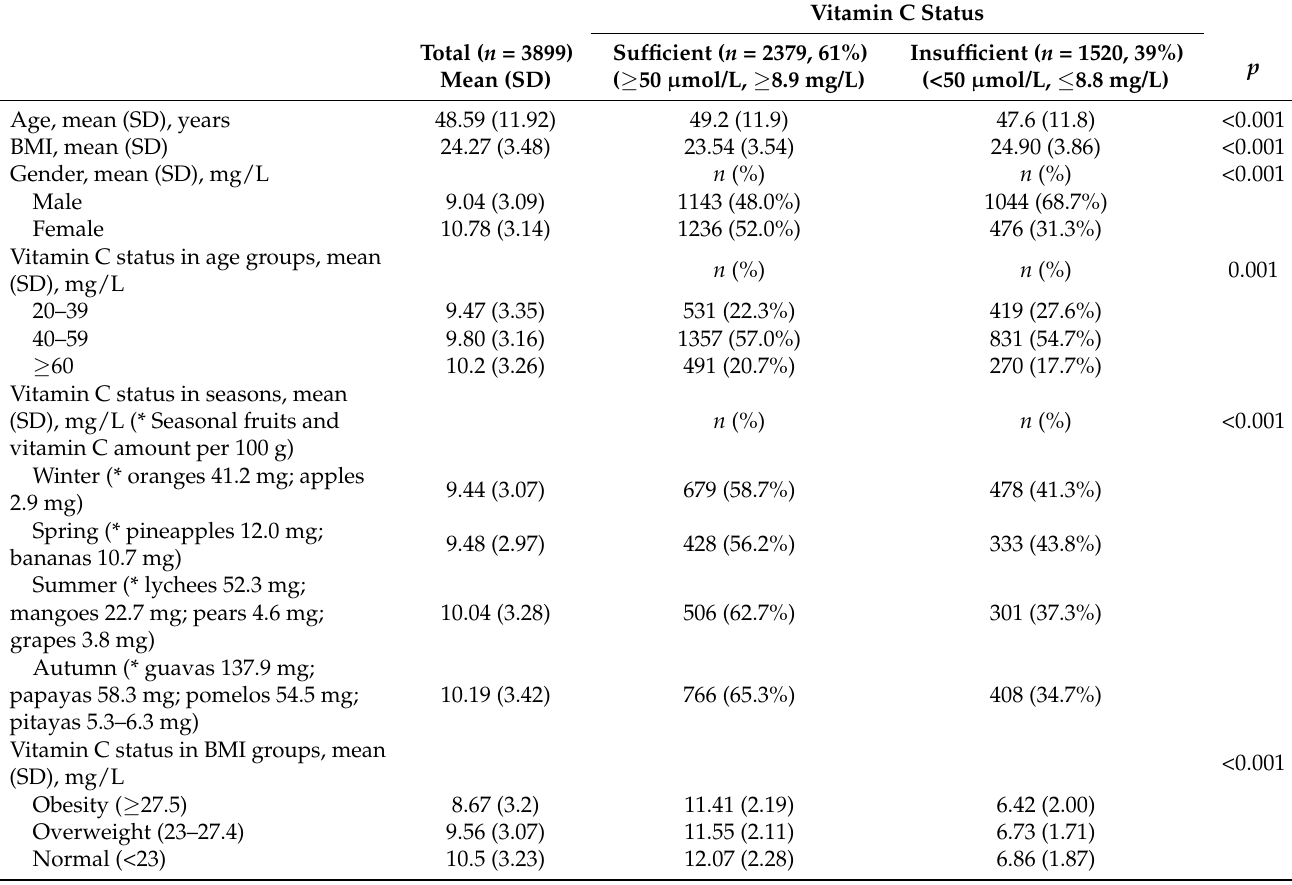
Table 1. Demographic and anthropometric characteristics of the study population in a subtropical